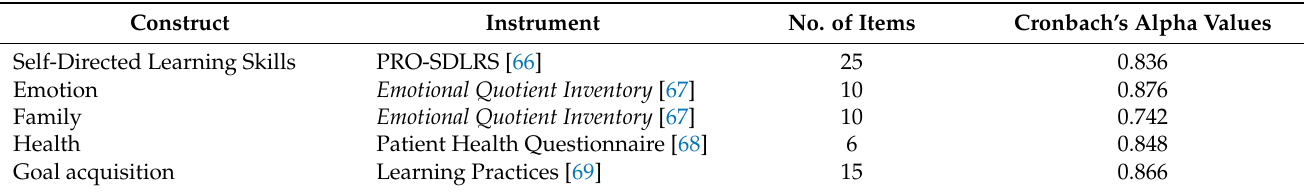
Table 1. Cronbach’s alpha values.